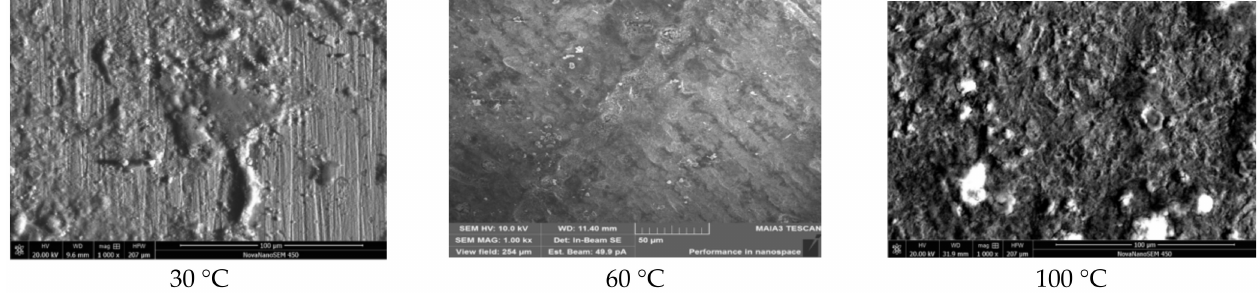
Figure 3. Surface microscopic corrosion profiles of 80S steel at different temperatures at a total pressure of 8 MPa.